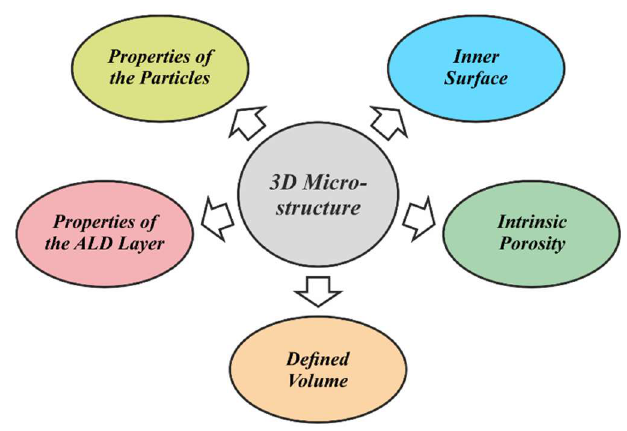
Figure 11. Physical and chemical properties of PowderMEMS 3D microstructures that can be tailored towards specific applications. Table 1. Exemplary list of possible applications of the PowderMEMS technology. The individual applications included in this table are presented and discussed in the following text.